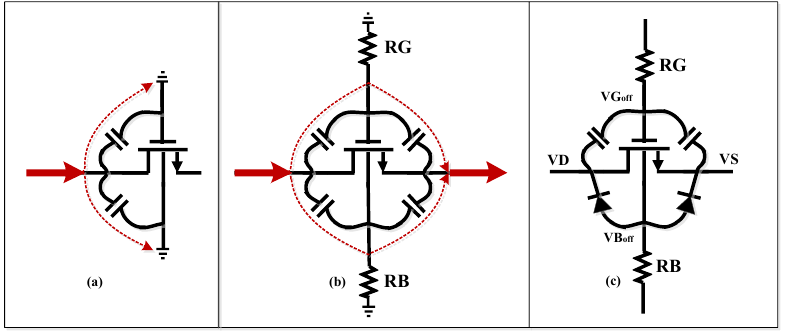
Figure 2. ( a ) Leakage path through junction capacitors, ( b ) blocking leakage current, ( c ) transistor model in off-state.